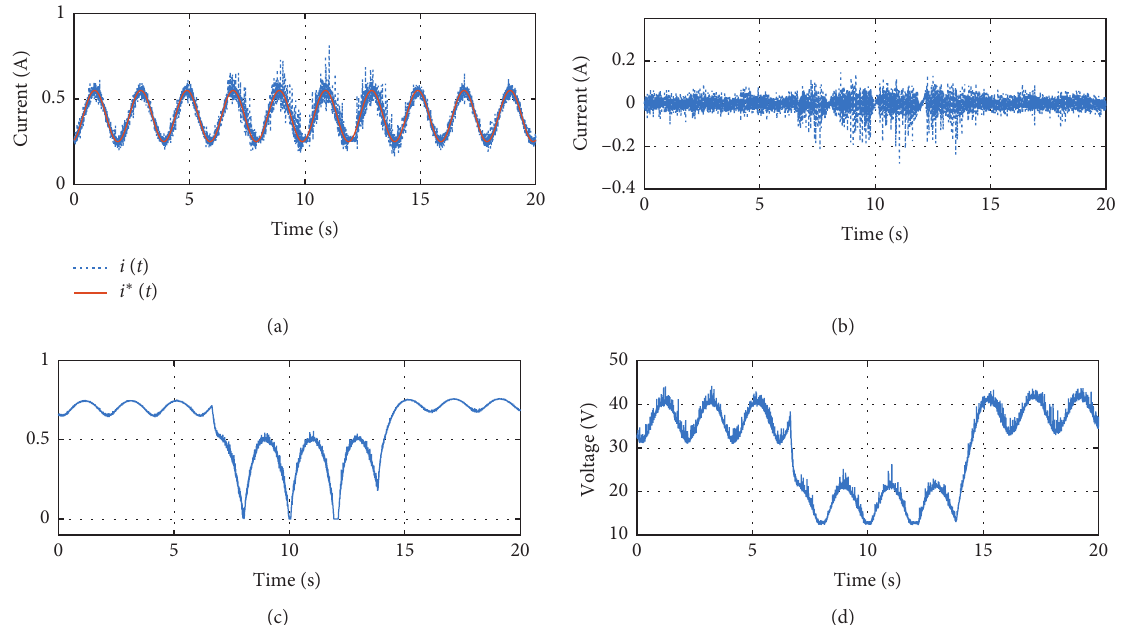
Figure 26: Boost converter response to path following with the SSTA controller. (a) Desired current and measured current. (b) Error. (c) Control action. (d) Output voltage.